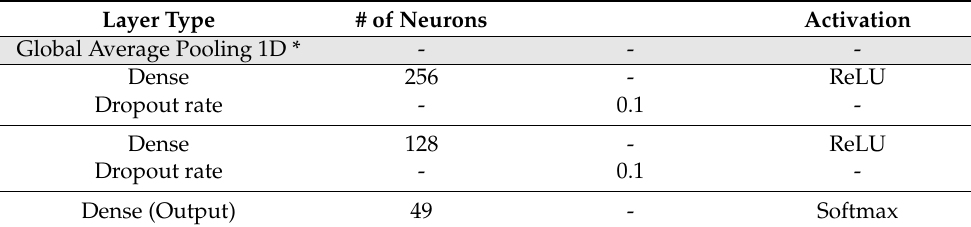
Table 1. DNN model architecture.